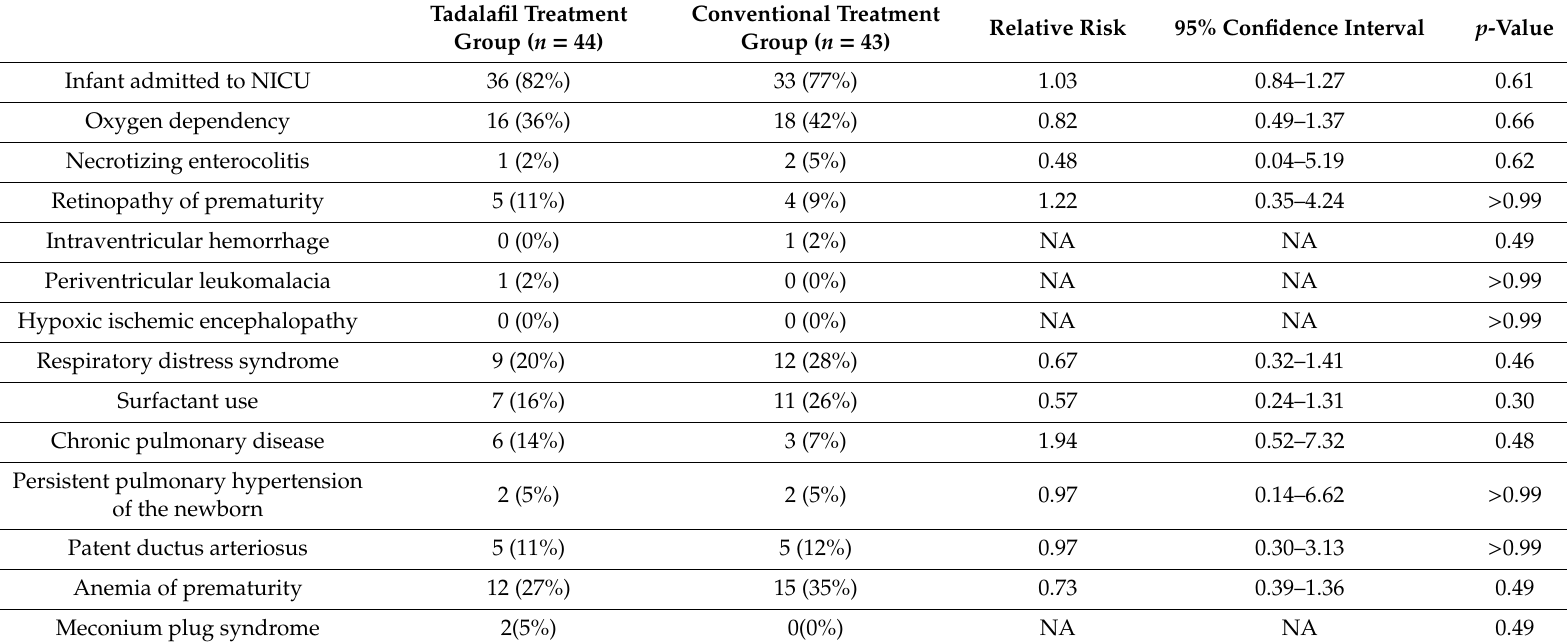
Table 5. Neonatal adverse